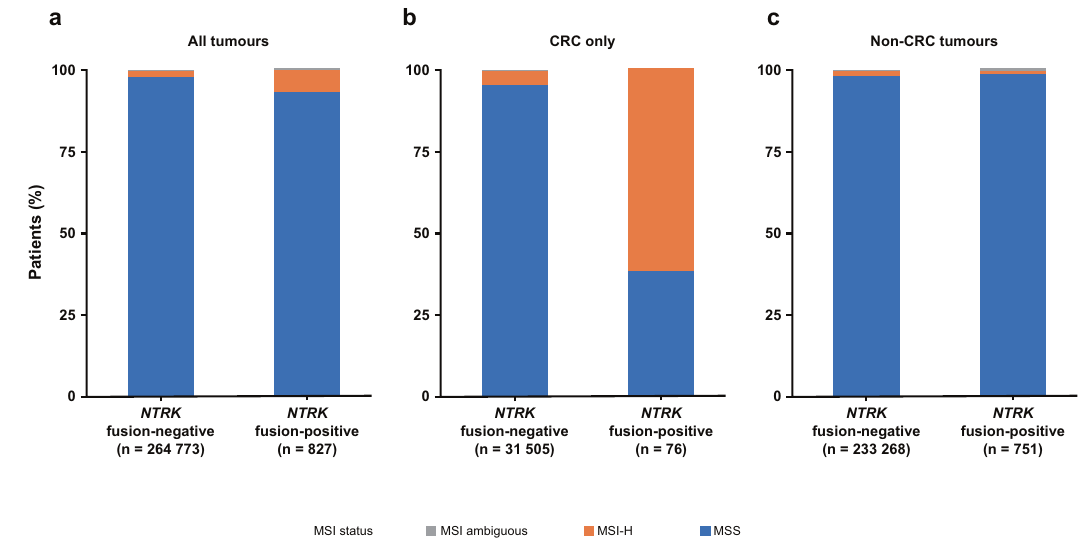
Fig. 4 Evaluation of and microsatellite instability (MSI) status in NTRK fusion-positive versus NTRK fusion-negative solid tumours. MSI status in all tumours ( a ), CRC only ( b ) and non-CRC tumours ( c ). CRC colorectal cancer, MSI-H microsatellite instability-high, MSS microsatellite stable, NTRK neurotrophic tyrosine receptor kinase.